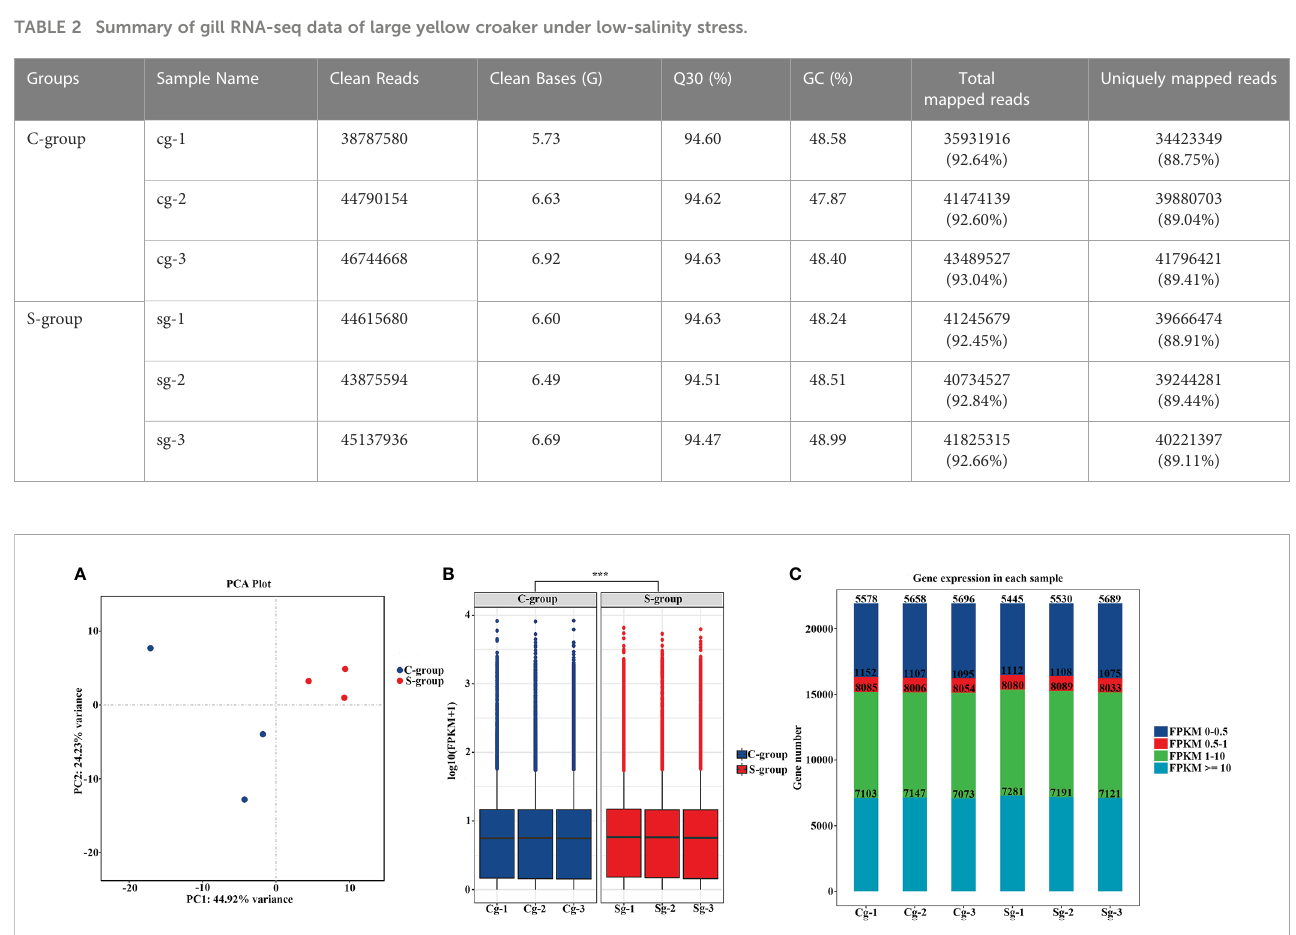
FIGURE 2 Assessment of low-salinity stress on gene expression. (A) PCA of gene expression levels among different salinity treatment; (B) Box plots showing the differences in gene expression levels between two salinity treatments; (C) Distribution of the expressed gene number based on the differences in FPKM value between the two salinity treatments. ***, represent the difference is extremely signi fi cant ( p <0.01).